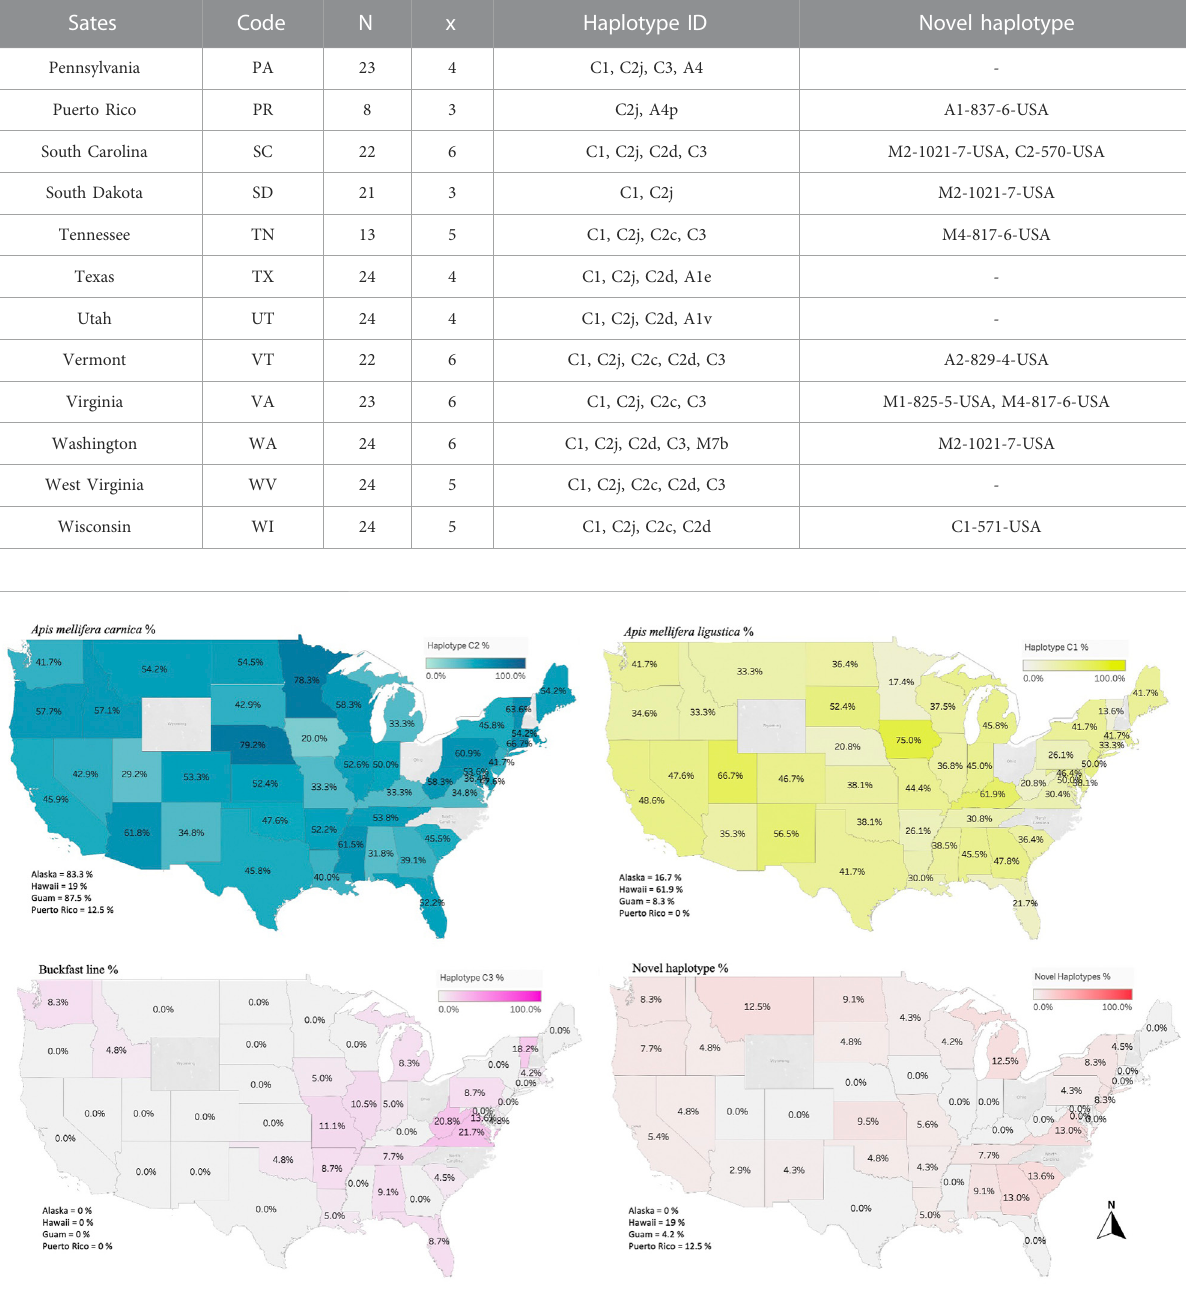
carnica , Figure 5A. The ND2 coding region demonstrated relatively similar evolution patterns found in the COI-COII region, particularly for C1 and C2j haplotypes, while C2d and C3 did not follow a clear pattern, Figure 5B. In sub fi gure 5b,